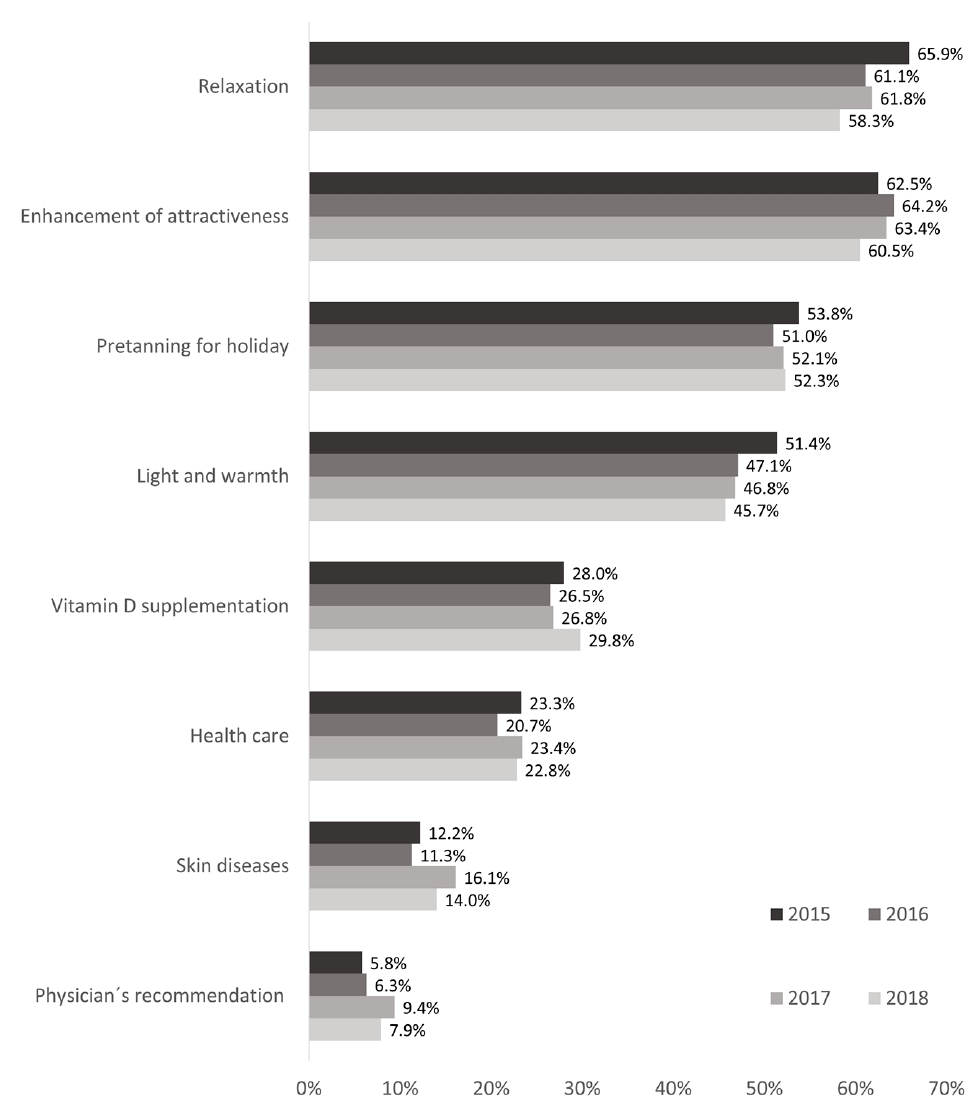
Figure 2. Reasons for tanning bed use from 2015 to 2018. Data are based on the waves 2015, 2016, 2017, and 2018 of the National Cancer Aid Monitoring (NCAM). Data are weighted by sex, age, and education to be representative for Germany. Shown are data on ever users aged 14 to 45 years.